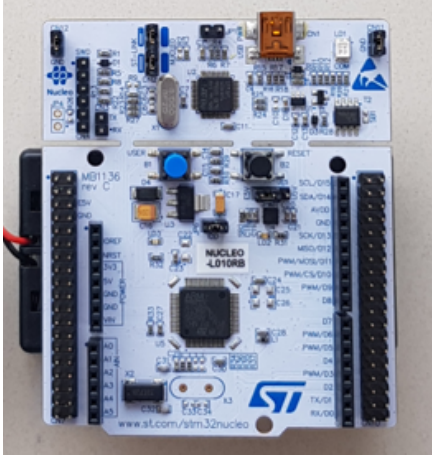
Figure 4. Appearance of Nucleo-L010RB.